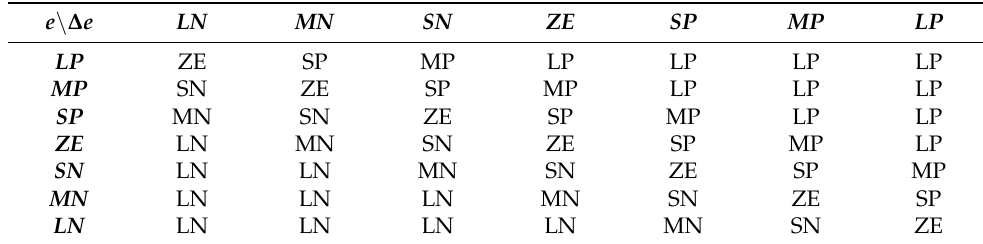
Table 1. Base of rules for FLC.